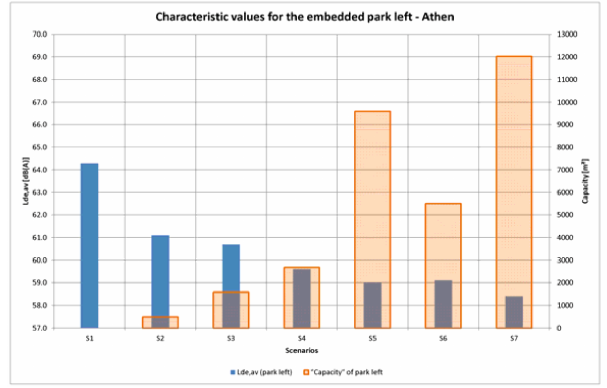
de , av and the capacity of Figure 22: Average (arithmetic) noise level L of the right hand side of the park in Athens in the various scenario